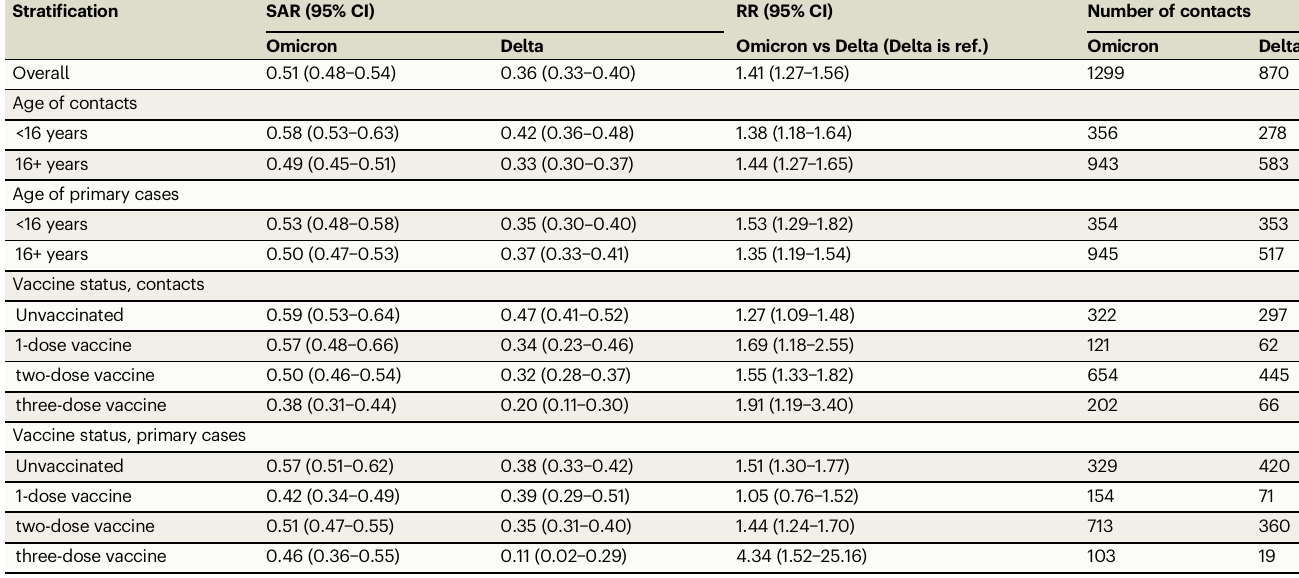
Table 1 | Ten-day secondary attack rate (SAR) of Omicron and Delta strati fi ed by age and vaccination status Strati fi